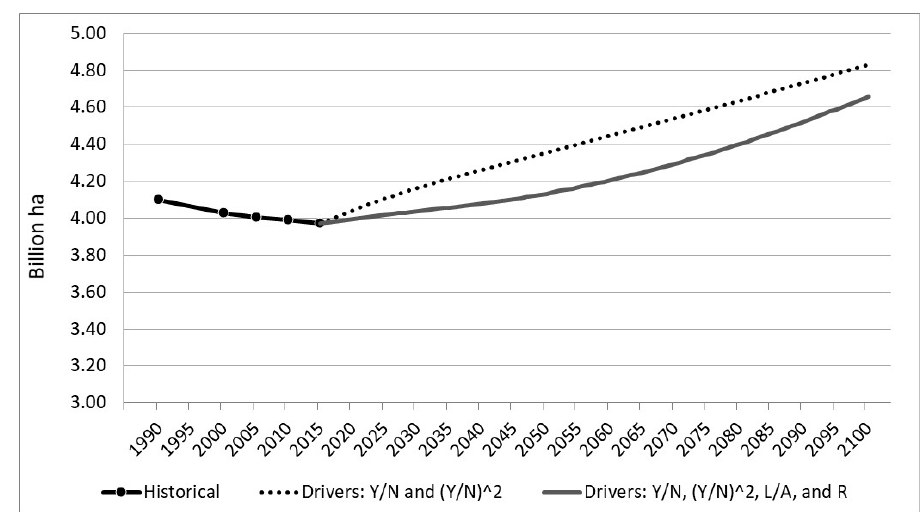
Figure 3. Projected global total forest area (billion ha) under shared socioeconomic pathways two (SSP2), 2015–2100. The dotted line shows forest area driven by only projected per capita income and its squared value, and the solid line shows the projections driven by per capita income, its squared term, rural population density, and labor per unit forest area. The results represent the sum of projections for 168 countries including 48 countries in Africa ( a ), 46 in Asia ( b ), 36 in Europe ( c ), 17 in North America ( d ), nine in Oceania ( e ), and 12 in South America ( f ).